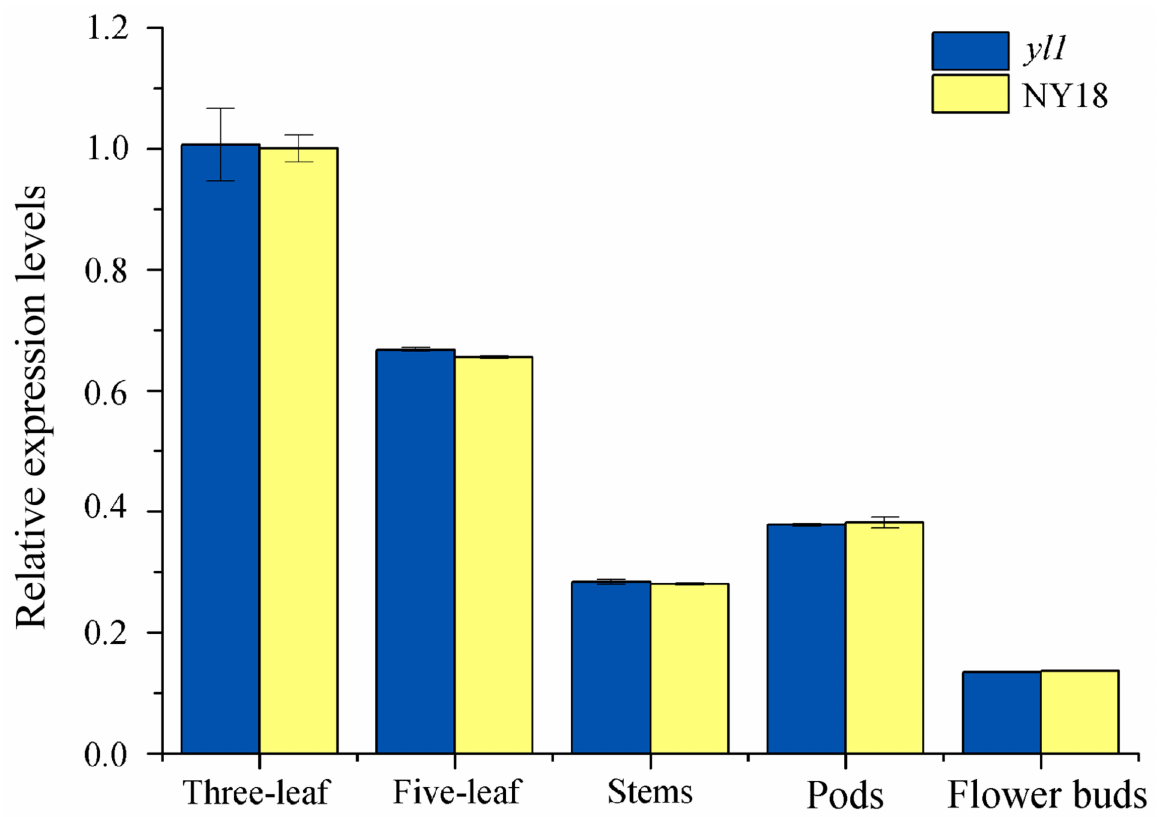
Figure 6. The expression level of BnaA03G0054400ZS in leaves, stems, pods, and flower buds of NY18 and yl1 , as determined by quantitative real-time PCR (qRT-PCR). The values are presented as the mean ± SD ( n = 3). The statistical analyses in this study were performed using one-way analysis of variance (ANOVA) and Fisher’s least significant difference (LSD)